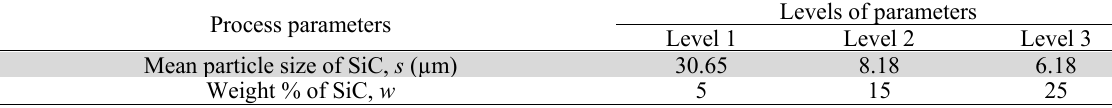
Levels of parameters Level 1 Level 2